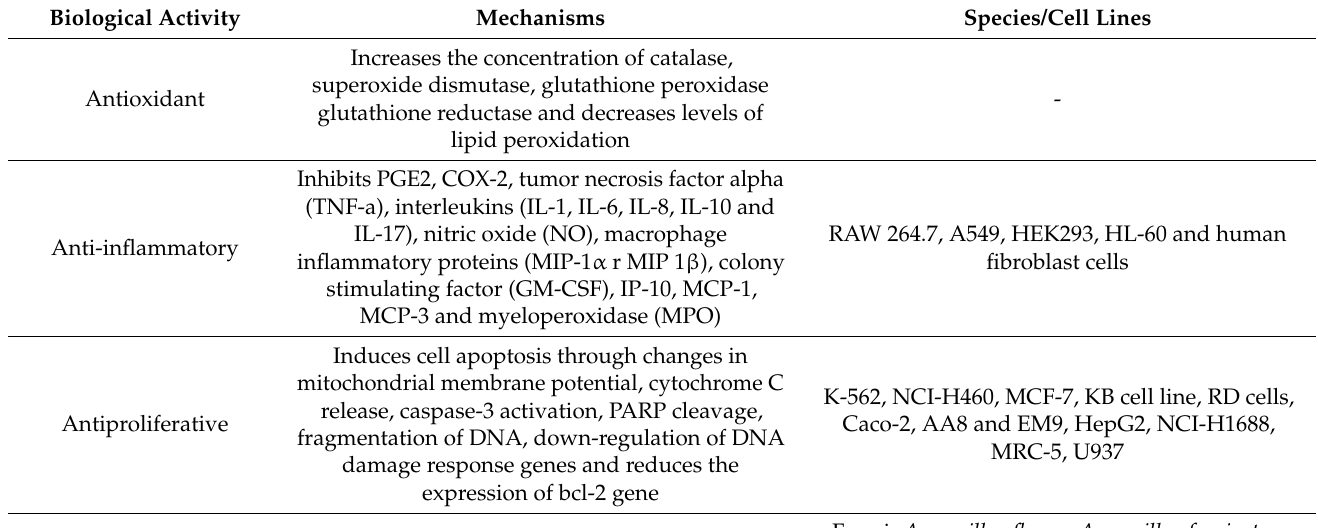
Table 1. The main biological activities of myristicin and its known